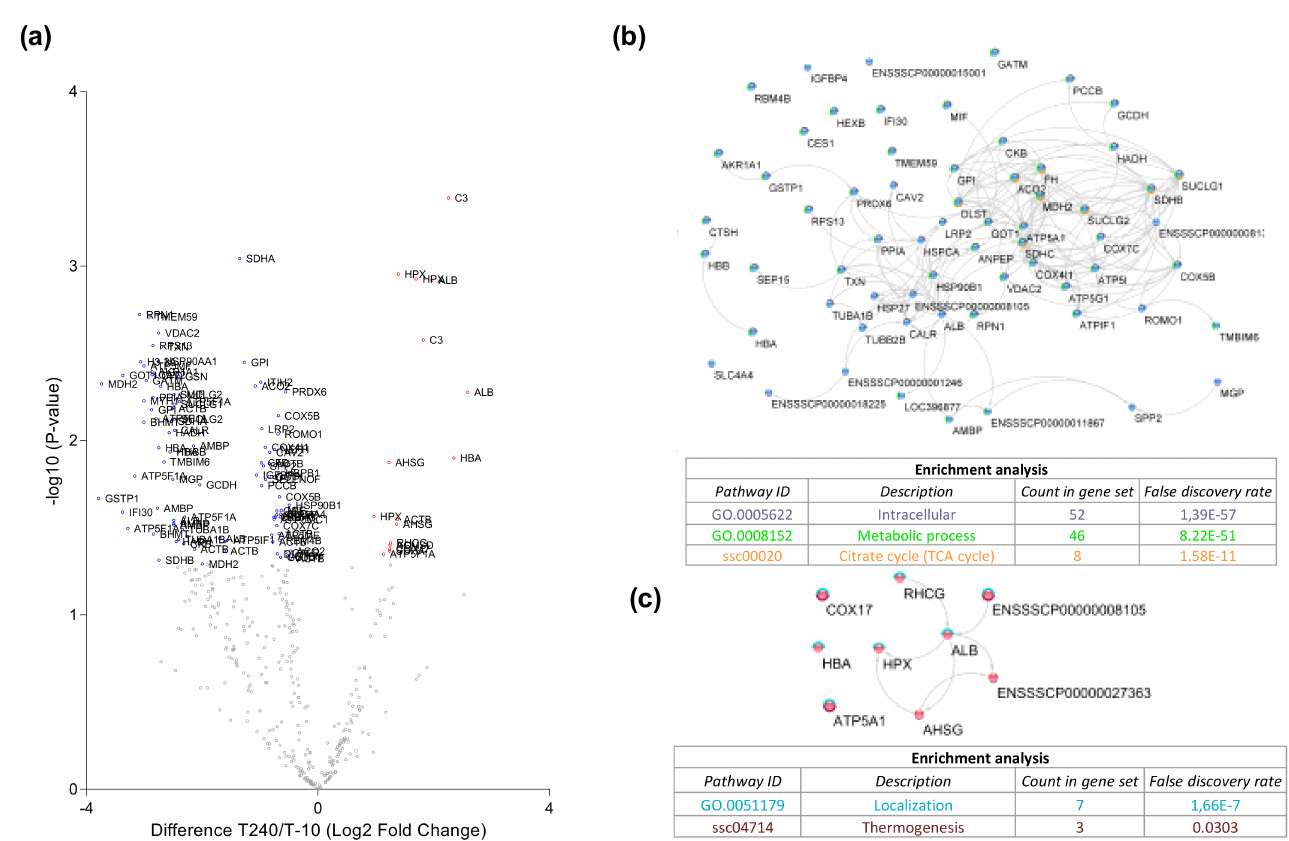
Figure 4. Kidney degradome dynamics during ex vivo reperfusion. ( a ) Log2 Fold Change in abundance between post (T240) and pre (T-10) reperfusion was plotted on the x -axis and the statistical significance of these changes on the y -axis as the -log10 ( p -value). Significantly downregulated degradation products (blue). Significantly upregulated degradation products (red). ( b ) String cluster and KEGG pathway analysis of degradation products significantly downregulated after reperfusion. ( c ) String clustering and KEGG pathway analysis of degradation products significantly upregulated after